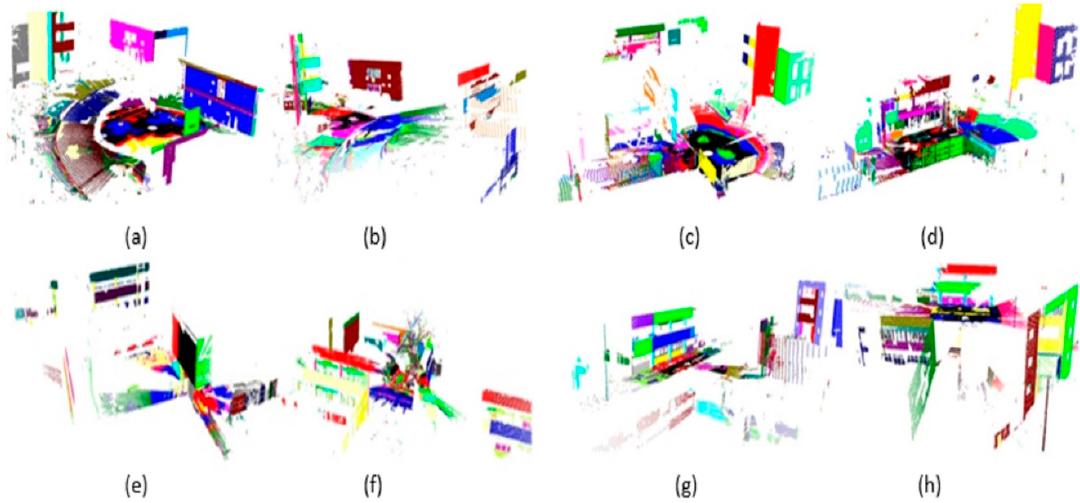
Figure 6. Segmented planes pair of point clouds using the RANSAC algorithm correspondent to the Patio Batel dataset. ( a ) Point cloud I. ( b ) Point cloud II. ( c ) Point cloud III. ( d ) Point cloud IV. ( e ) Point cloud V. ( f ) Point cloud VI. ( g ) Point cloud VII. ( h ) Point cloud VIII. The planes were classified and segmented into horizontal and vertical planes, with their normals and perpendicular distances calculated with respect to the origin. The error xy and error z threshold values were respectively 0.15 and 0.01 m for Patio batel and Lape datasets, while for the Royal exhibition building dataset, the value 0.01 m was used for error xy and error z